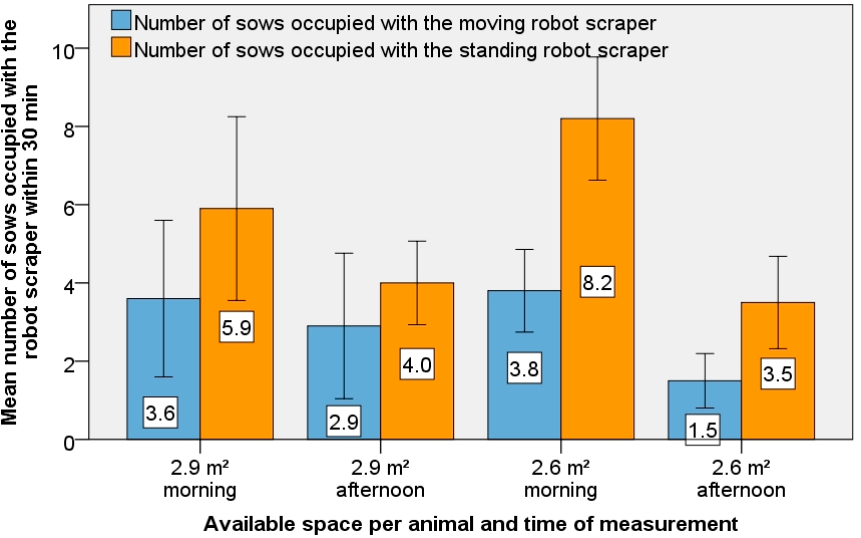
Figure 7. Representation of the average number of sows occupied with the moving or standing robot scraper in the morning and afternoon, with different space of 2.9 square metres per sow (left) or 2.6 square metres per sow (right).